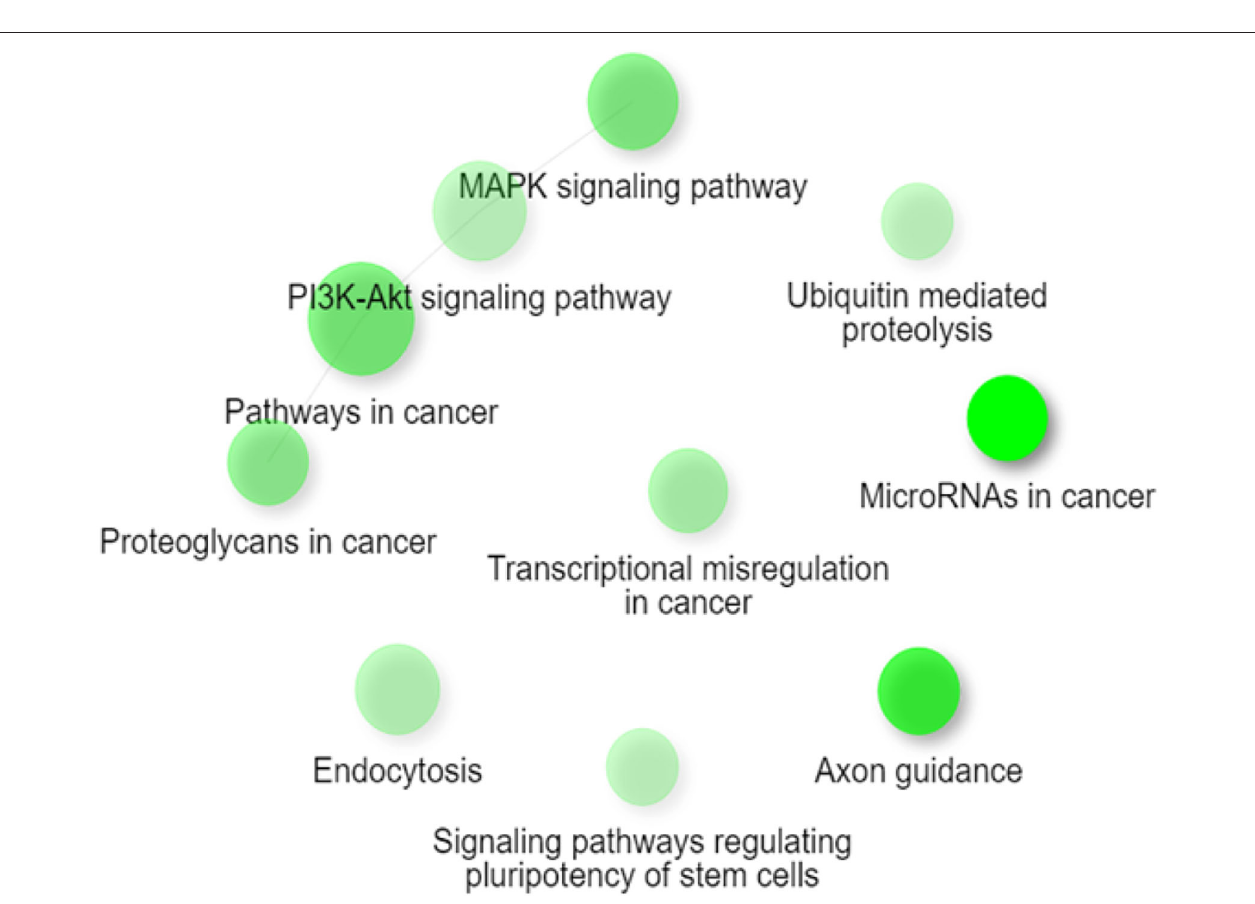
FIGURE 2 | Network figure showing the relationship between the enriched pathways obtained from the classification from KEGG. The nodes in green correspond to an enriched pathway, and their size is related to a set of larger genes. MAPK signaling, PI3K-Akt signaling pathway, pathways in cancer, and proteoglycans in cancer are connected as they share ≥ 20% of genes. Figure extracted from ShinyGO